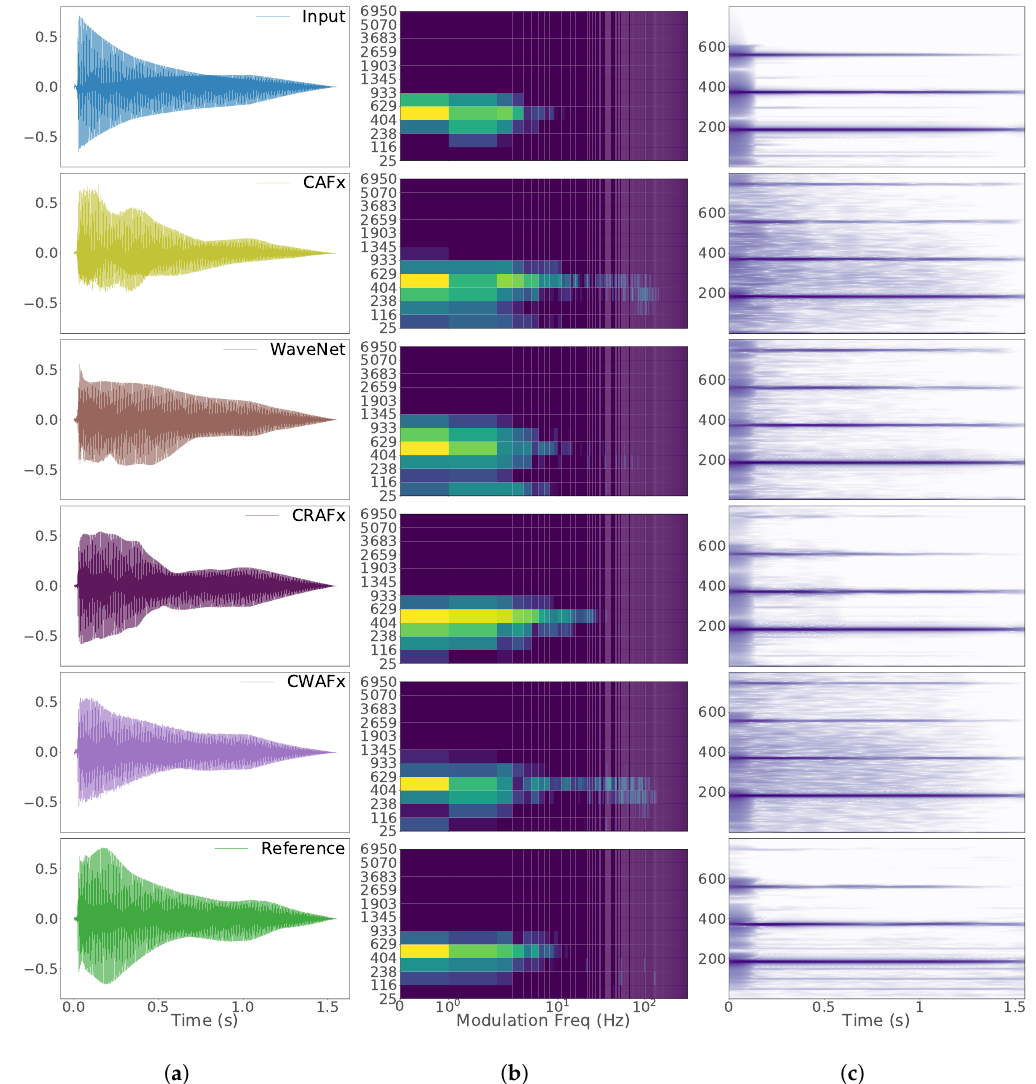
Figure 12. Results with selected samples from the test dataset for the Leslie speaker woofer-chorale tasks. ( a ) Waveform, ( b ) modulation spectrum and ( c ) spectogram. Vertical axes represent amplitude, Gammatone frequency (Hz) and FFT frequency (Hz),